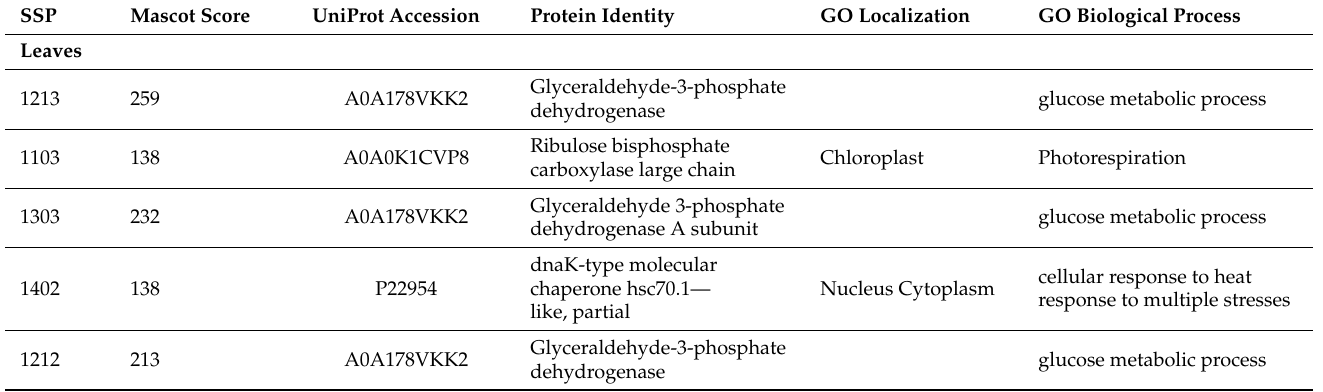
Table 3. MS/MS identified protein spots, down-regulated in leaves and stem of Cuscuta australis — parasitized Arabidopsis thaliana . SSP is the standard spot